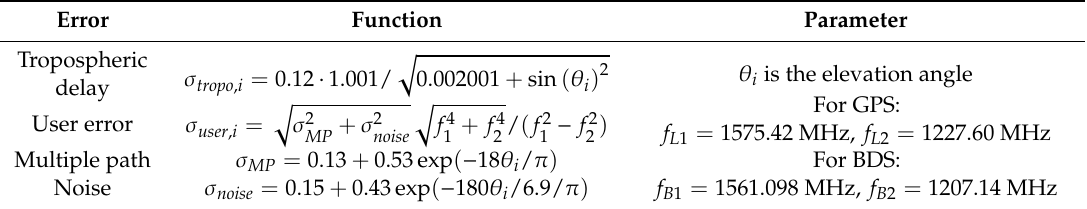
12 of 21 Table 2. Error model. Error